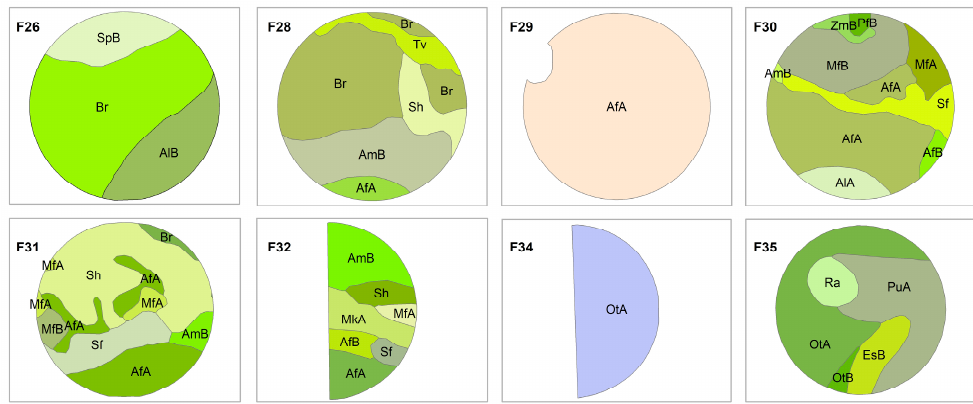
Figure 3. Soil map units in eight fields in the Southern High Plains. AfA: Amarillo fine sandy loam, 0–1% slopes (Fine-loamy, mixed, superactive, thermic Aridic Paleustalfs); AfB: Amarillo fine sandy loam, 1–3% slopes (Fine-loamy, mixed, superactive, thermic Aridic Paleustalfs); AIA: Amarillo loam, 0–1% slopes (Fine-loamy, mixed, superactive, thermic Aridic Paleustalfs); AIB: Amarillo loam, 1–3% slopes